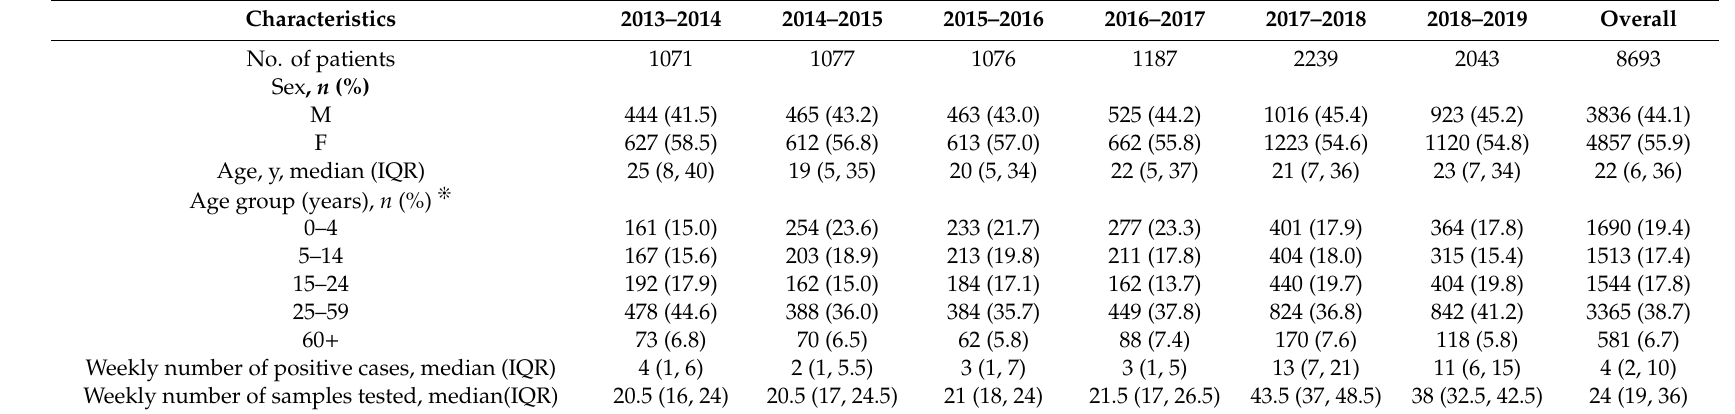
Table 1. Demographic characteristics of influenza-like illness (ILI) 1 cases from two sentinel surveillance sites in Yichang, Hubei, 2013-2019. Characteristics